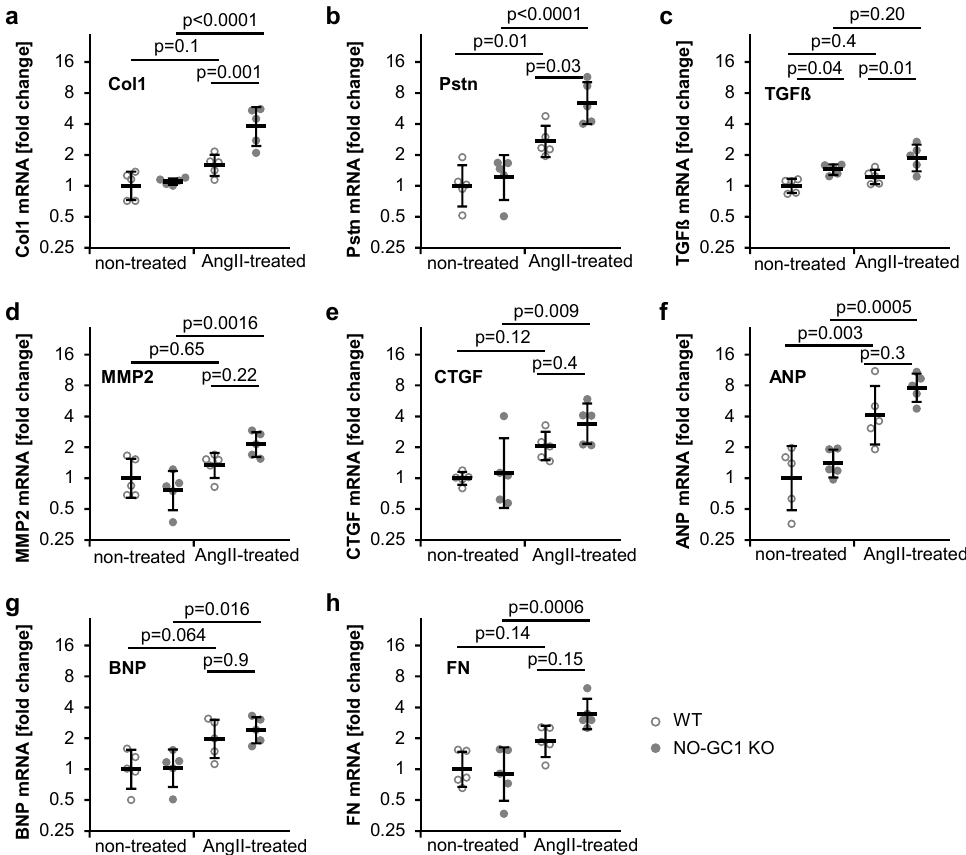
Figure 5. Cardiac mRNA of proteins implicated in fibrosis are increased in AngII-treated NO-GC1 KO compared to WT mice. mRNA levels of ( a ) collagen 1 ( b ) periostin ( c ) TGF β ( d ) matrix metalloproteinase 2 ( e ) CTGF ( f ) ANP ( g ) BNP, and ( h ) fibronectin were determined using quantitative real-time PCR in heart sections from WT and KO mice under non-treated and AngII-treated conditions. ∆∆ Ct values to GAPDH and subsequently to non-treated WT were calculated and statistically analyzed. For graphical representation, 2 −∆∆ Ct values were calculated and are shown in semi-log plots. Shown are individual values (per animal) together with geometric means ± geometric SD.